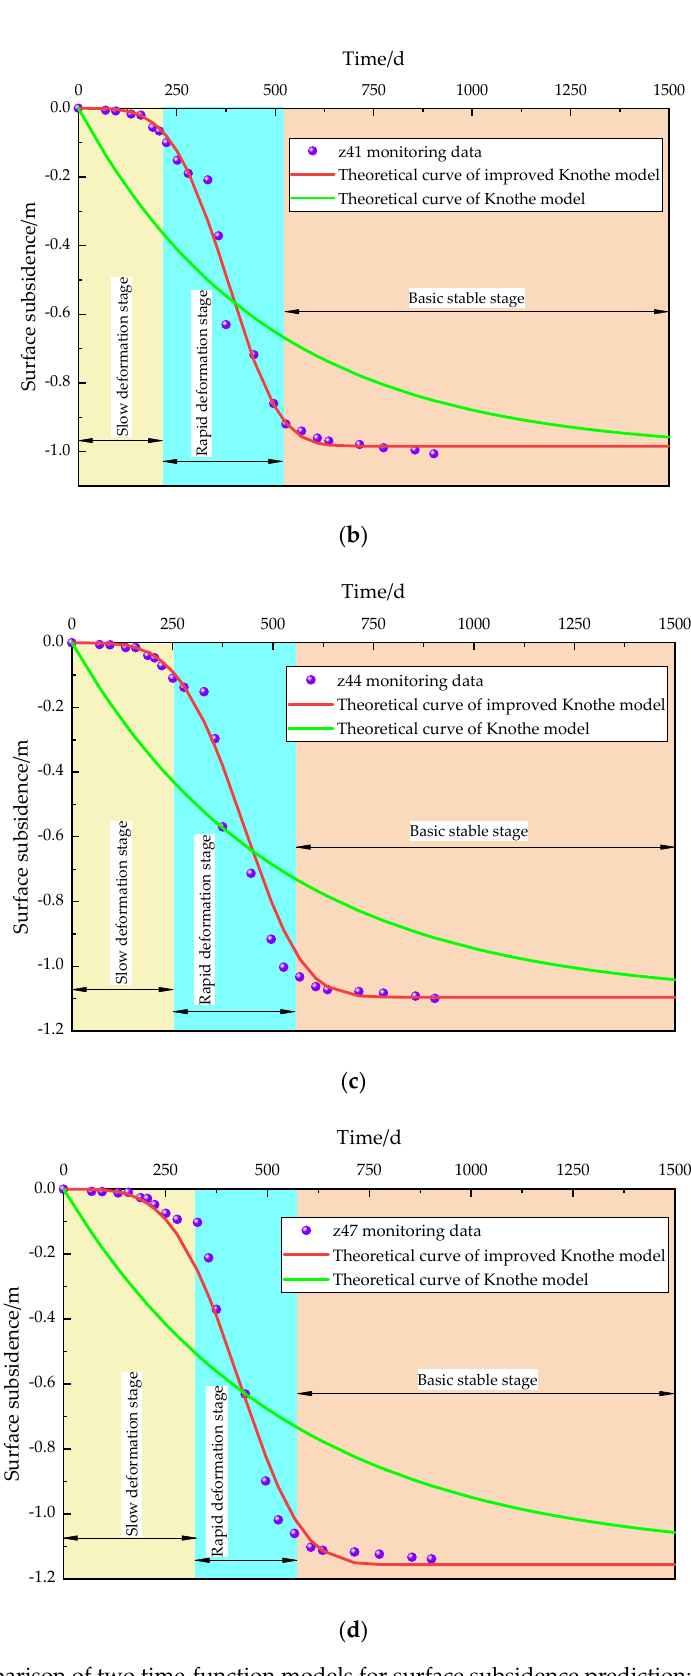
Figure 8. Comparison of two time-function models for surface subsidence prediction: ( a ) z38; ( b ) z41; ( c ) z44; ( d ) z47. ( c ) z44; ( d )